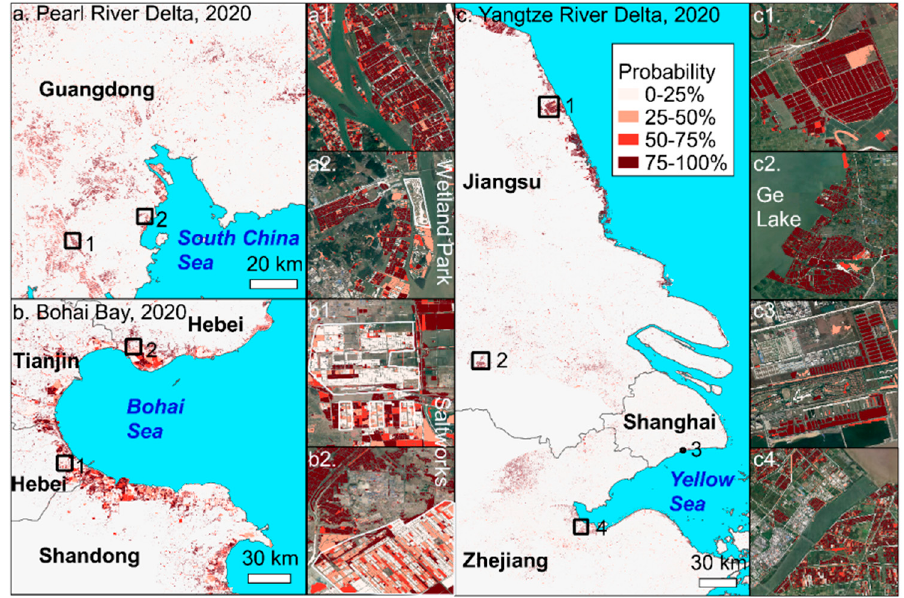
Figure 9. Probability maps of aquaculture ponds at different MFs based on 2019 Sentienl-2 MSI images. ( a ) indicates the probability map of aquaculture ponds in the Pearl River Delta; ( a1 , a2 ) refer to the detailed mapping of the two positions 1 and 2 in ( a ). ( b ) indicates the probability map of aquaculture ponds in Bohai Bay. ( b1 , b2 ) refer to the detailed mapping of the two positions 1 and 2 in ( b ). ( c ) indicates the probability map of aquaculture ponds in the Yangtze River Delta. ( c1 – c4 ) refer to the detailed mapping of the four positions of 1, 2, 3, and 4 in ( c ).